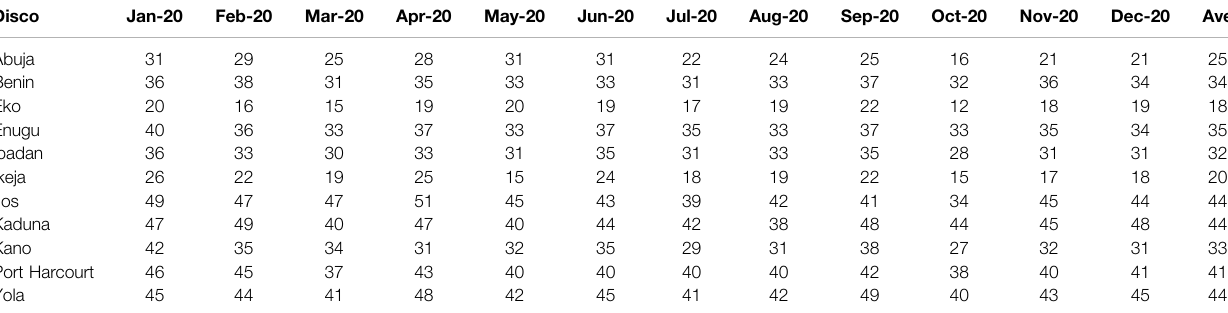
TABLE 7 | 2020 projection of Discos % ATC&C owing to 25% metering scale-up (GWh). Disco Jan-20